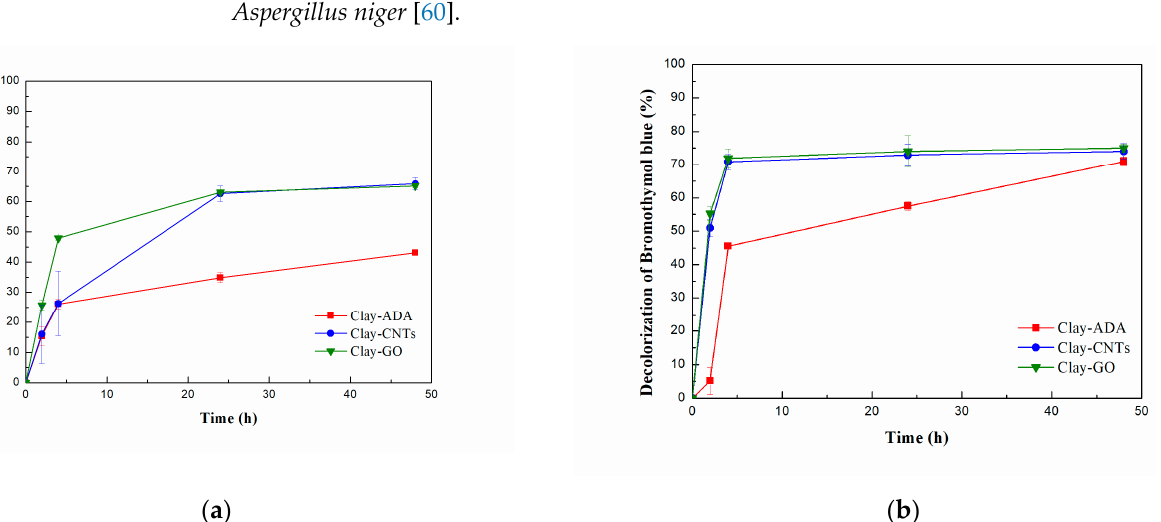
Figure 2. Decolorization yield (%) of bromothymol blue by ( a ) non-covalently and ( b ) covalently immobilized TvL on hybrid nanomaterials.